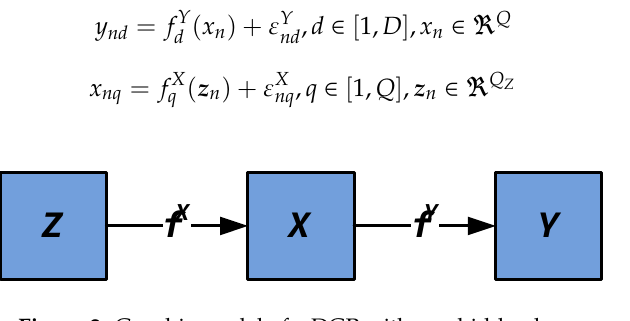
Figure 2. Graphic model of a DGP with one hidden layer.